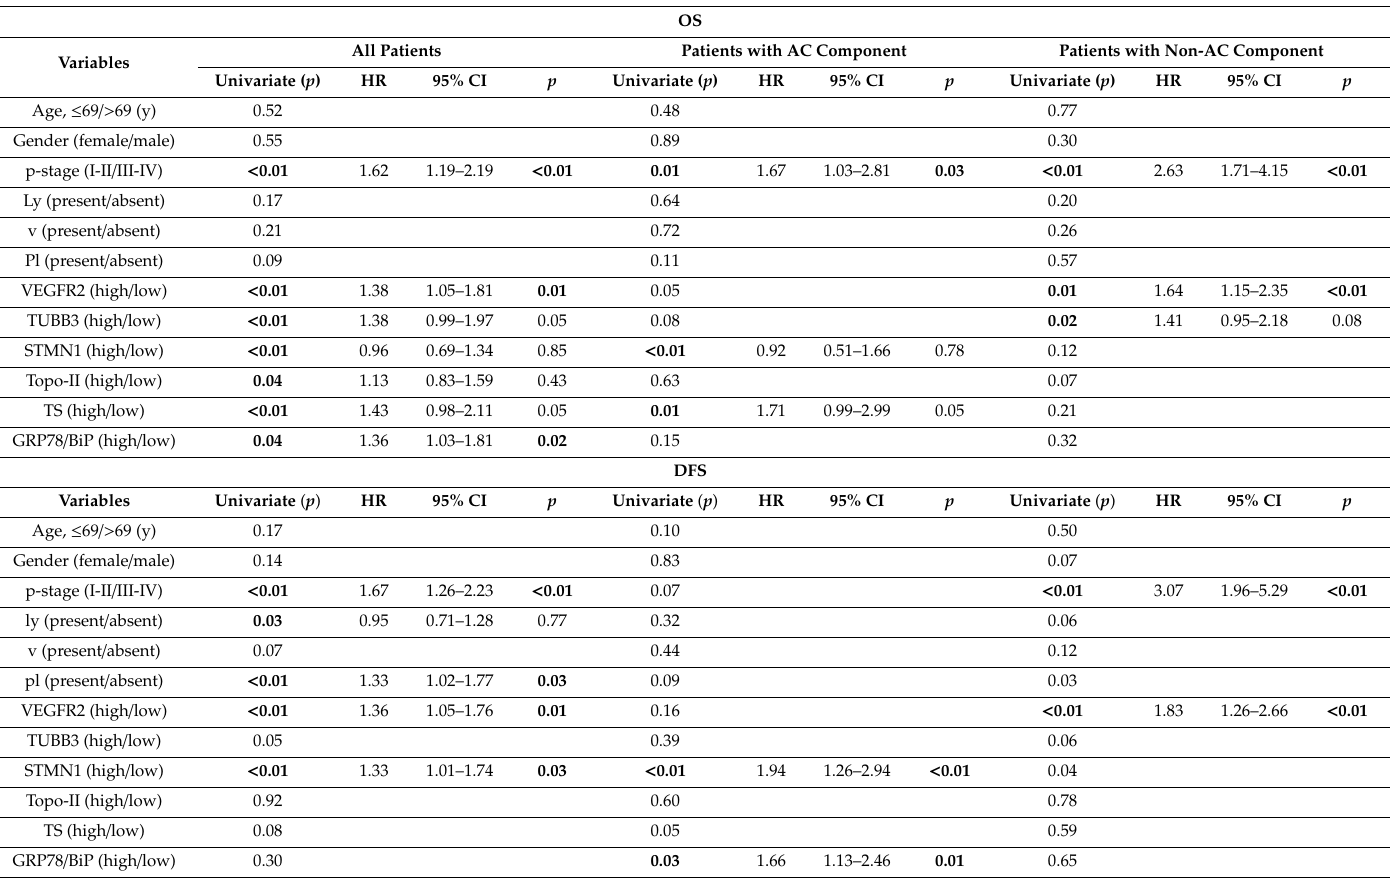
Table 4. Multivariate OS and DFS